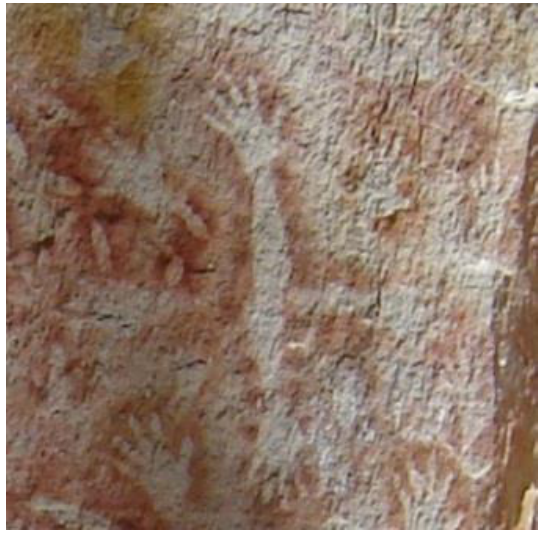
Figure 25. Carnarvon Gorge, Queensland, Australia. Courtesy B.